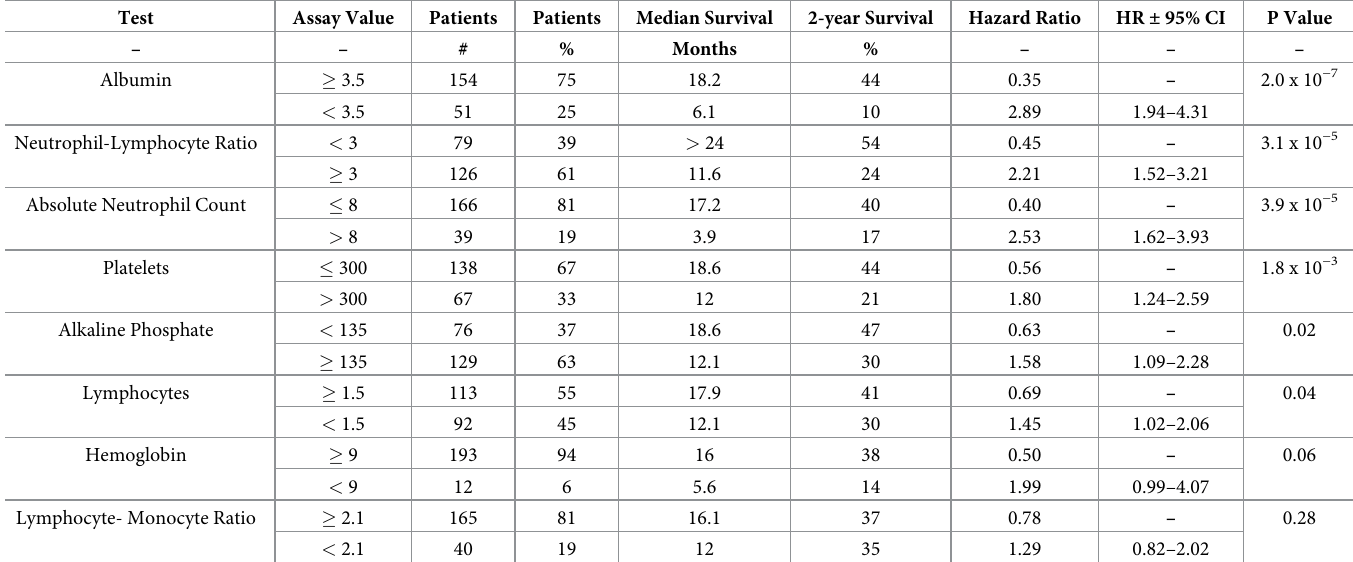
Table 4. Combined GI cancers single prognostic characteristics and